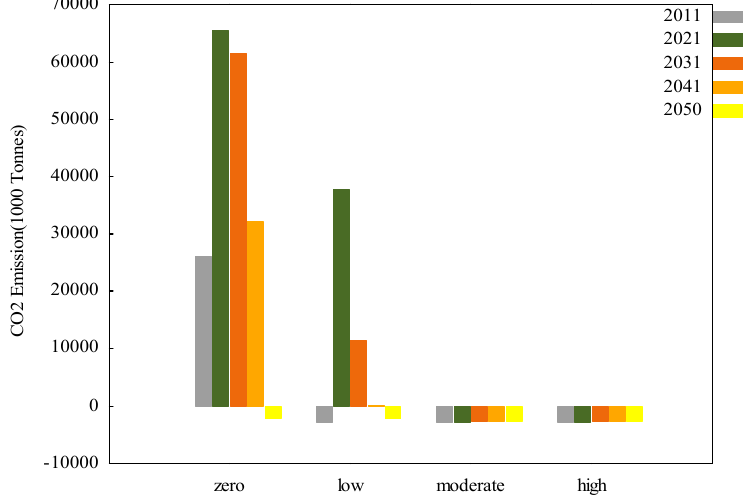
Figure 6. Total greenhouse gas (GHG) emission under subsidy action.